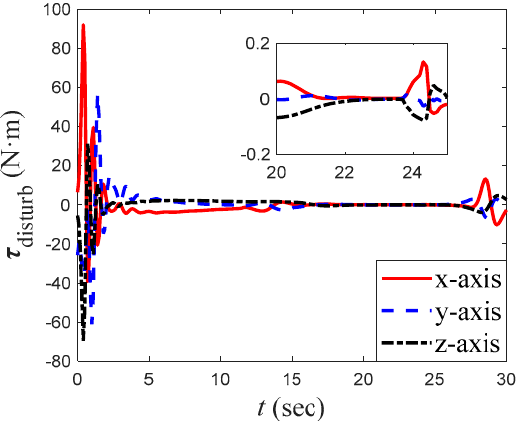
Figure 17. Disturbing torque of manipulators to the platform.